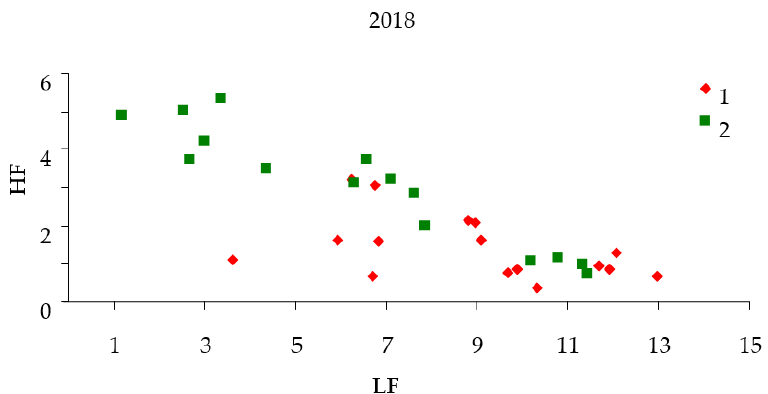
Figure 8. LF and HF parameters after outbreak of black fir sawyer (2018). 1—damaged areas; 2—control stands.